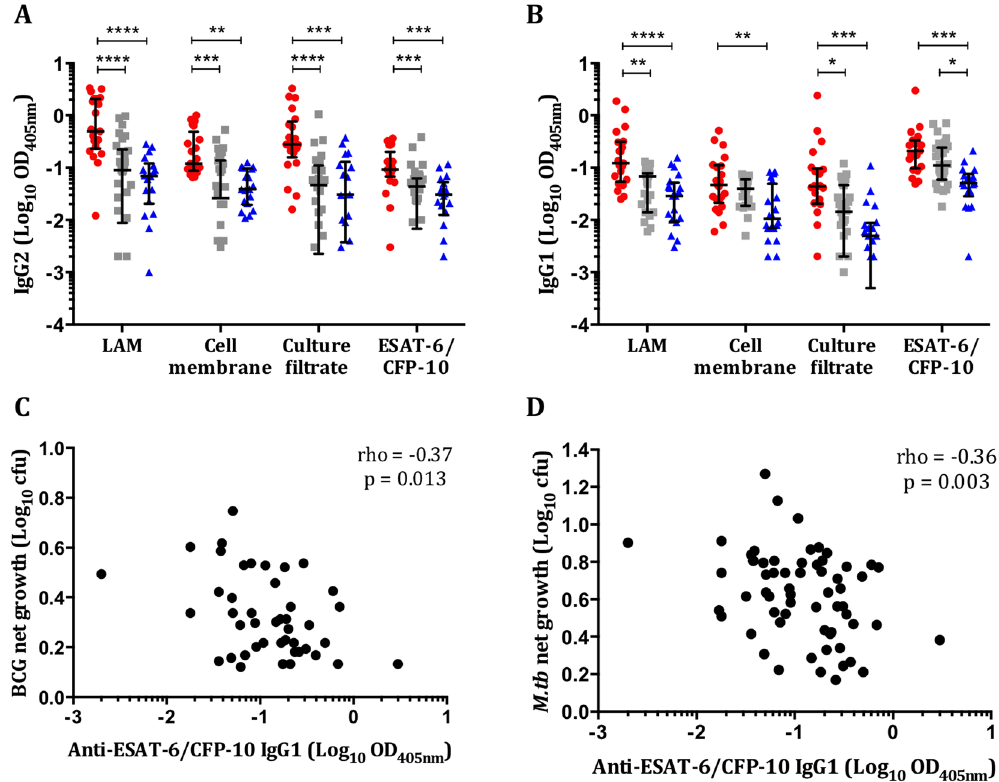
Figure 5. IgG1 responses to RD1 restricted M . tb -specific antigens are negatively correlated with mycobacterial net growth. Antigen-specific IgG2 ( A ) and IgG1 ( B ) responses in pre-treatment samples from active TB (n = 21), LTBI (n = 30) and healthy control individuals (n = 20) were determined by ELISA. Negative correlations between IgG1 responses to ESAT-6/CFP-10 and BCG ( C ) and M . tb H37Rv ( D ) net growth were seen. Antigens used were M . tb H37Rv-derived LAM, cell membrane fraction, culture filtrate and ESAT-6/ CFP-10. Optical densities (ODs) are reported following subtraction of the background and plotted on a Log 10 scale. Points represent the mean of duplicates and bars are the median values with the interquartile range. After normality testing a Kruskal-Wallis test with Dunn’s correction for multiple comparisons was performed for each antigen. * Represents a p-value of < 0.05, ** a p-value of < 0.01, *** a p-value of < 0.005 and **** a p-value of < 0.0001. Spearman’s rho and associated p-values are shown. Red circles = active TB, grey squares = LTBI and blue triangles = healthy